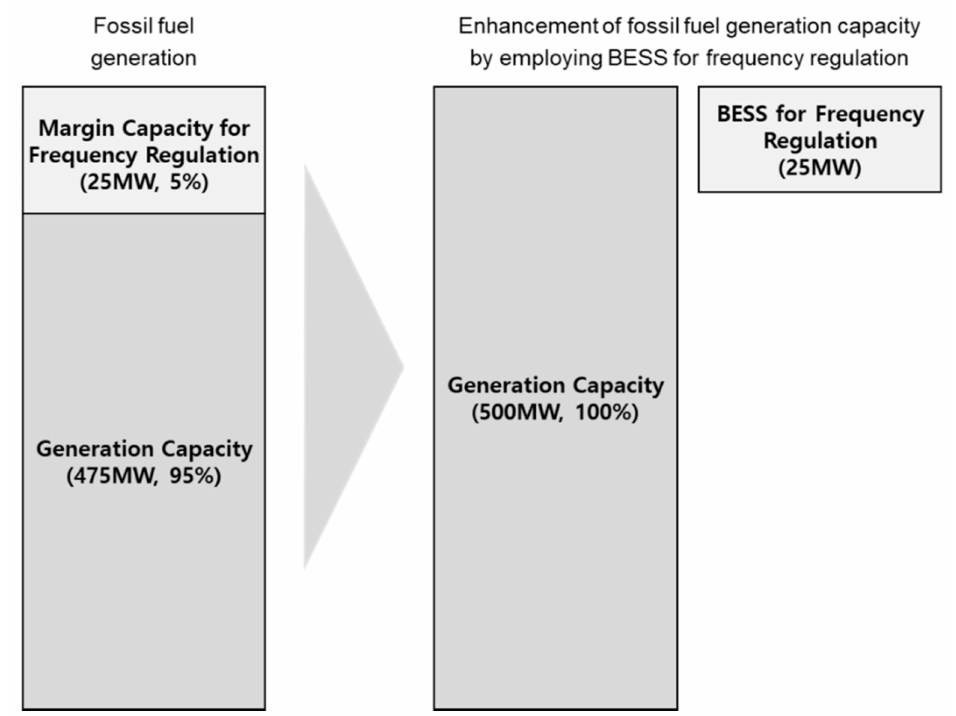
Figure 1. Example of increasing generation capacity by employing BESS for FR